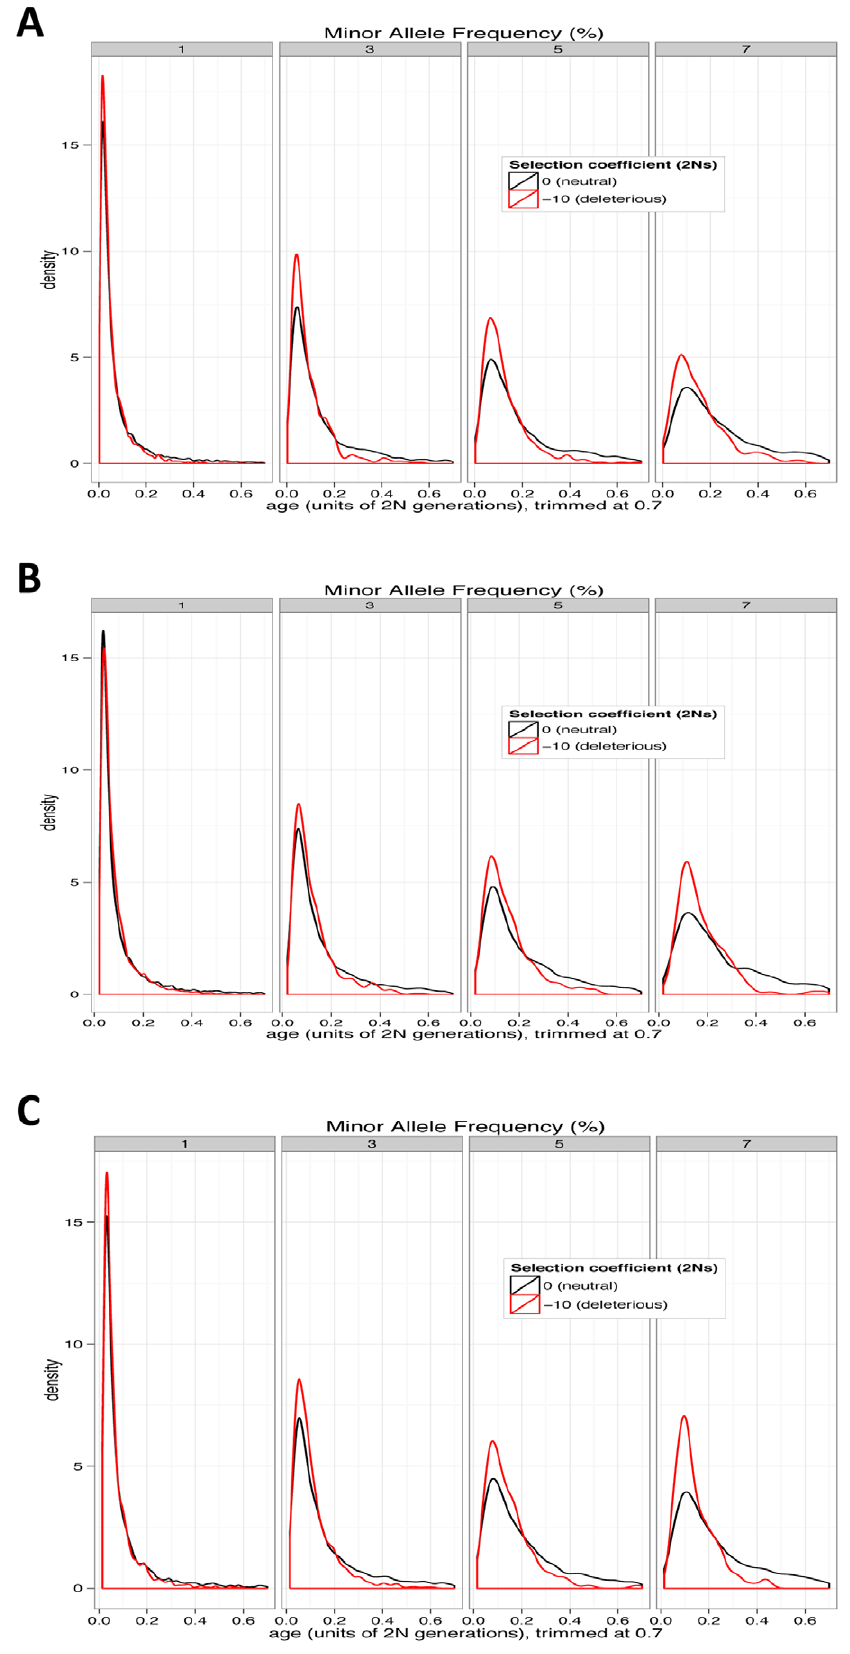
Figure 2. Age distributions for neutral and deleterious alleles from simulations. (A) Constant-size, (B) recently rapidly expanding population, and (C) bottleneck followed by rapid expansion. For presentation, distributions are trimmed. Deleterious alleles in all cases are younger than neutral alleles at the same frequency, though the effect is weaker in rapidly expanding populations. doi:10.1371/journal.pgen.1003301.g002 PLOS Genetics | www.plosgenetics.org 4 February 2013 | Volume 9 | Issue 2 |